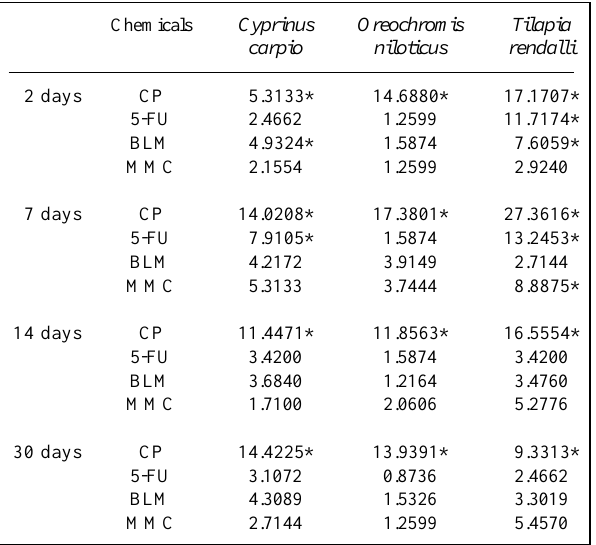
Table I - Increase rate of micronucleus frequencies in three fish especies (treatment/control),